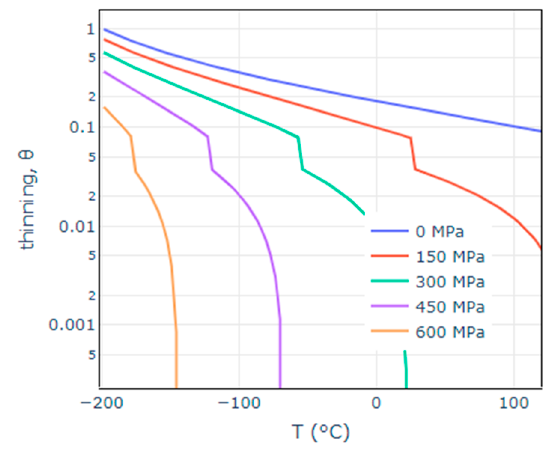
Figure 1. Poisson thinning vs. temperature for a range of shear stresses.